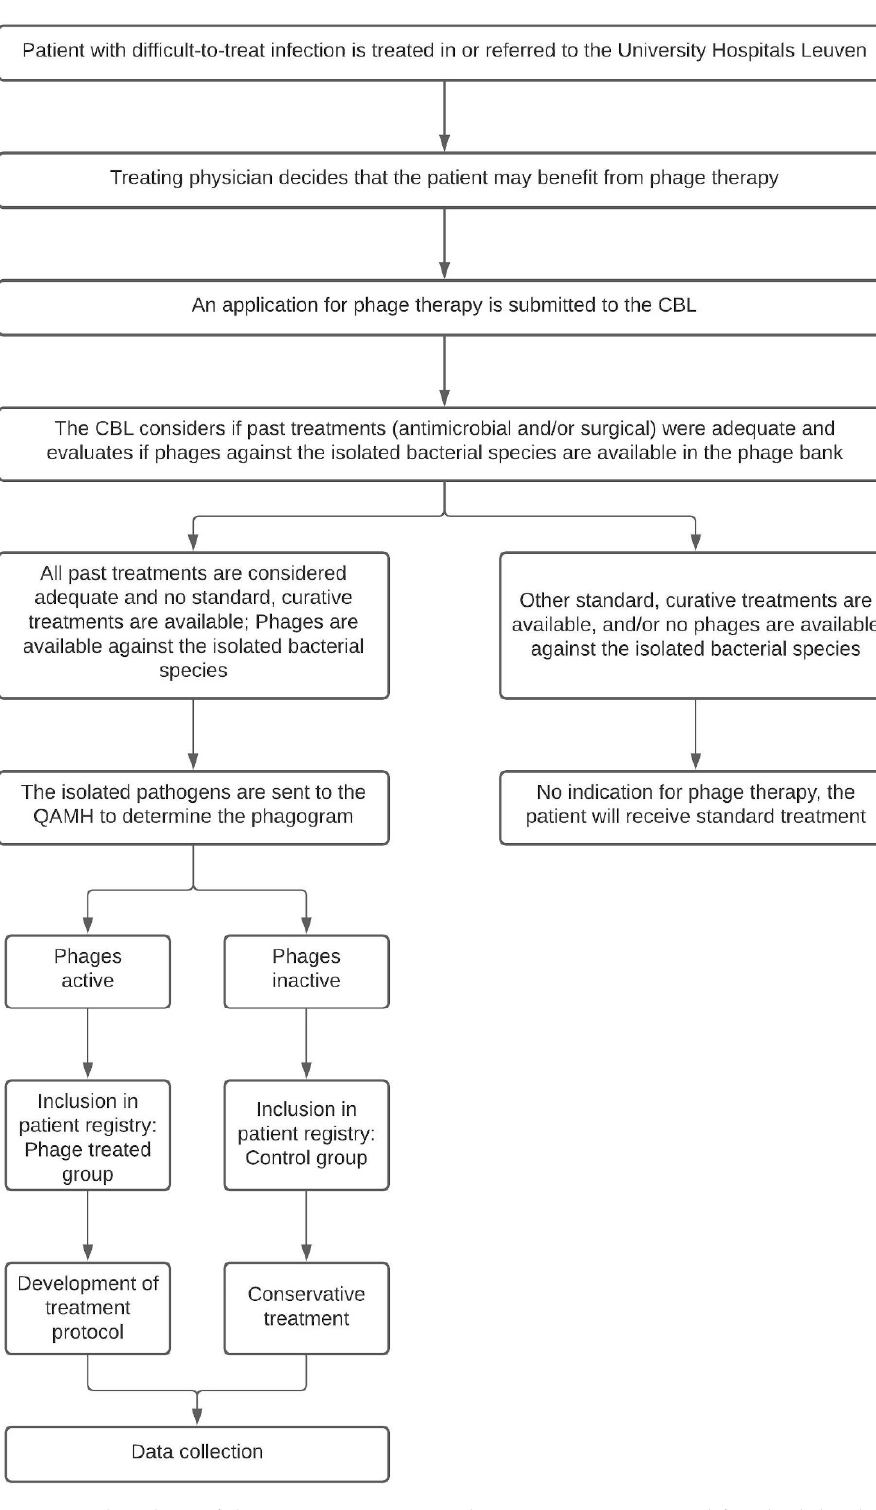
Figure 1. Flowchart of the PHAGEFORCE study. Patients are screened for eligibility by the CBL. Based on the availability of active phages, the patient can (phage treatment group) or cannot (control group) be treated with phage therapy. Regardless of which group the patient is in, all data related to the infection will be collected. CBL: Coordination group for Bacteriophage therapy Leuven; QAMH: Queen Astrid Military Hospital.